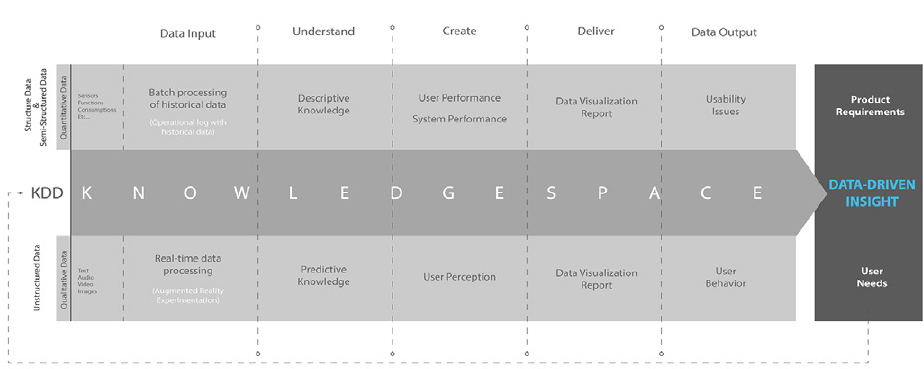
Figure 5. Data transformation flow into design material (source: created by